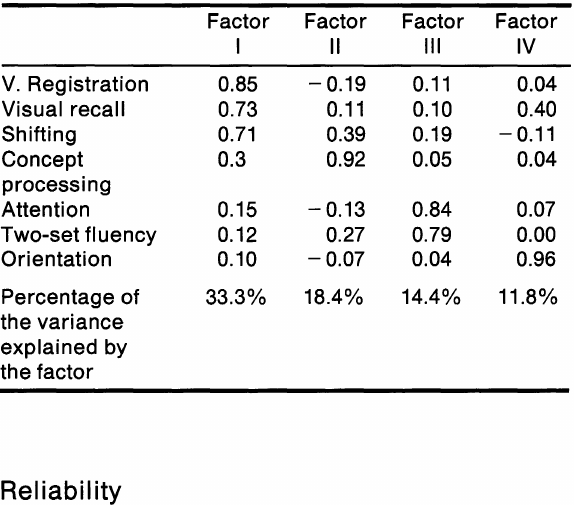
TABLE VI. Factors loading for each variable in the factor analysis (orthogonal solution, varimax rotation). Vertical lines indicates large